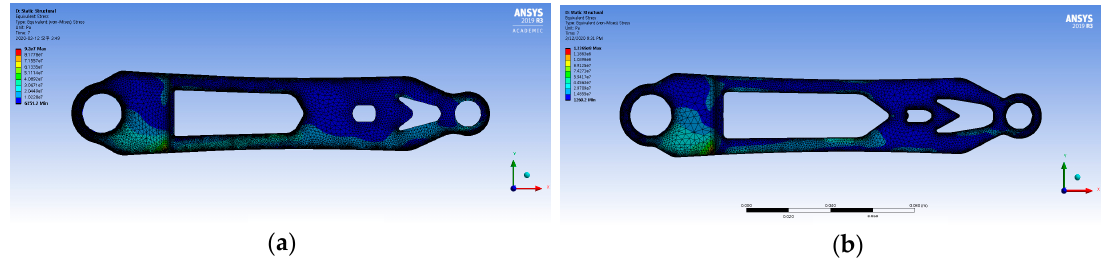
Figure 11. Effect of stress constraint in mass minimization: (a) 80% yield strength, ( b ) 90% yield Figure 11. E ff ect of stress constraint in mass minimization: ( a ) 80% yield strength, ( b ) 90% yield strength. strength.